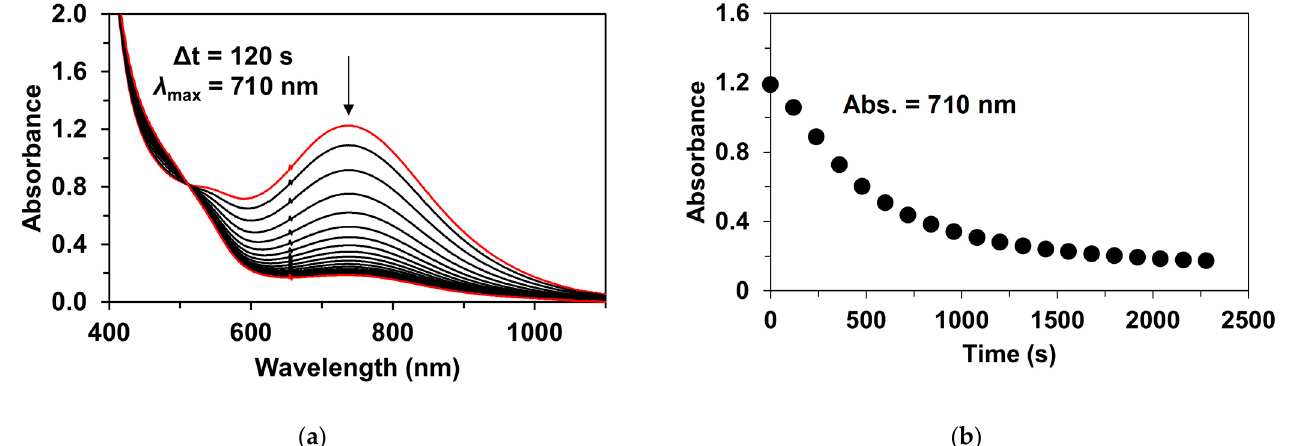
Figure 3. Self-decay of [Fe III2 ( µ -O 2 )(L 2 ) 4 (Solv) 2 ] 3+ ( 4 P ) generated in the reaction of 4 with 4 equivalent of H 2 O 2 . ( a ) UV–Vis spectral change during the decay of 4 P . ( b ) Time course of the self-decay of 4 P : [ 4 ] 0 = 1.0 × 10 − 3 M, [H 2 O 2 ] 0 = 4.0 × 10 − 3 M, l = 1 cm, V = 2 mL MeCN; k sd = 1.955 × 10 − 3 s − 1 for 1 P and 1.177 × 10 − 3 s − 1 for 4 P at 298 K.